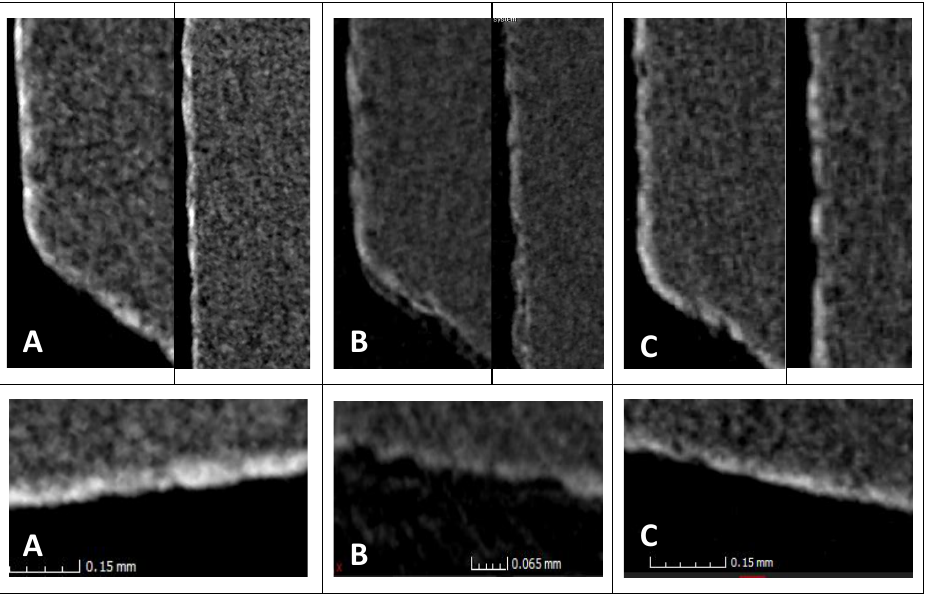
Figure 5. Images of tablet coatings acquired using X-ray microtomography: ( A ) unexpired tablets; ( B ) expired tablets; ( C ) stressed tablets. From the cross-sectional images of the unexpired tablets, it was found that the coat- ings were smooth, visually of similar density over the entire surface, and well-adhered to the tablet core. Areas of rough and non-uniform texture, as well as areas with clear dis- continuity in the coating layer, were observed in the coatings of the expired tablets and the stressed tablets. 3.3. Hyperspectral Analysis The reflectance levels of expired and unexpired tablets with nifuroxazide are plotted in Figure 6. The expired and unexpired spectra had absorption peaks in similar ranges. Both upward-going peaks (at 920 nm, 1008 nm, and 1020 nm) as well as downward-going peaks (at 943 nm, 1005 nm, 1011 nm, and 1030 nm) can be observed. Hyperspectral profiles of the three types of tested tablets are presented in Figure 6. In each image, the blue curve is the maximum reflectance, the orange curve is the average reflectance, and the grey curve corresponds to the minimum reflectance. Table 6 contains the results of the differences between the maximum and minimum reflectances of the an- alyzed tablets. The mean difference between the maximum and minimum reflectance cor- responds to the homogeneity: the greater the difference, the lower the homogeneity.